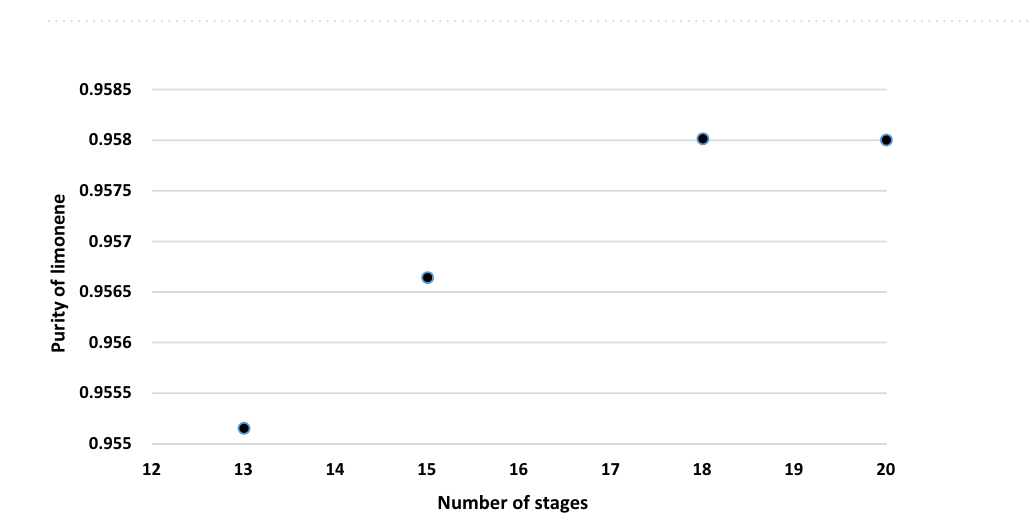
Table 3. ( a ) Final RADFRAC column parameters for first distillation column, ( b ) Final operating parameters for the second distillation column.